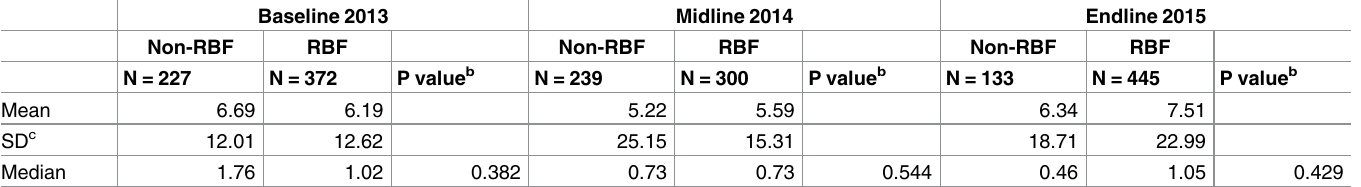
Table 3. Summaryof costs (US$) a of care in women with self-reported complication, by group and survey